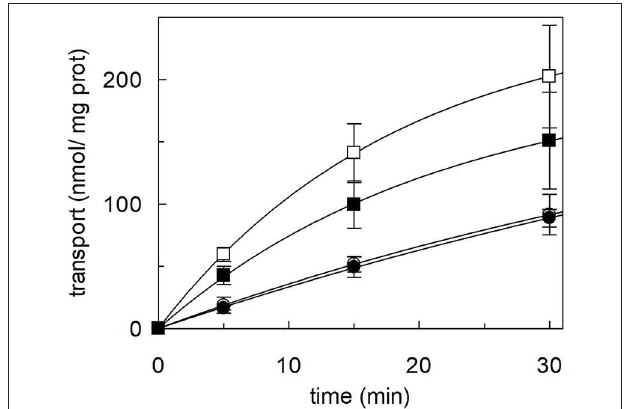
FIGURE 7 | Effect of Koshland’s reagent on cholesterol stimulation of hASCT2 reconstituted in proteoliposomes. Purified hASCT2 was incubated (•, (cid:4) ) or not ( ◦ , (cid:3) ) with 0.5mM Koshland’s reagent prior reconstitution. After treatment with the Koshland’s reagent, the protein was reconstituted in proteoliposomes prepared without CHEMS ( ◦ , •) or with 75 µ g/mg phospholipids CHEMS ( (cid:3) , (cid:4) ) as described in Materials and Methods. Transport assay was started adding 50 µ M of [ 3 H]glutamine and 50mM Na-Gluconate to proteoliposomes containing 10mM glutamine. Transport was stopped as described in Materials and Methods at the indicated time points. Values were plotted according to the first-order rate equation. Data are means ± SD of three independent experiments.